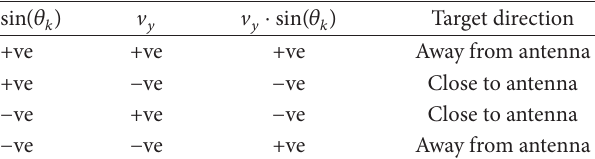
Table 2: Target direction estimation cases.